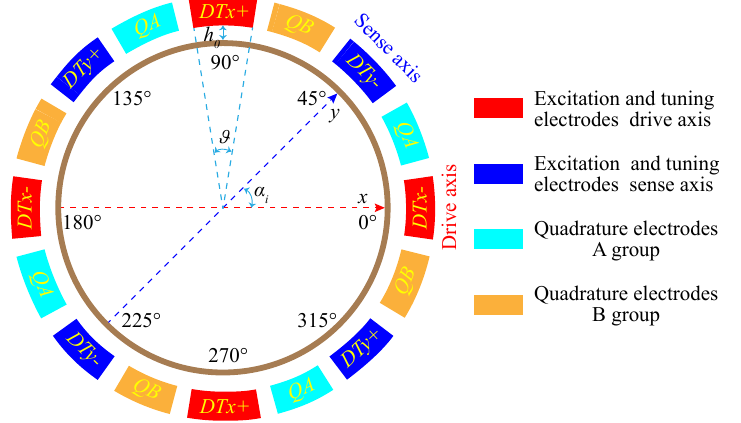
Figure 3. Distribution schematic of 16 external electrodes of the